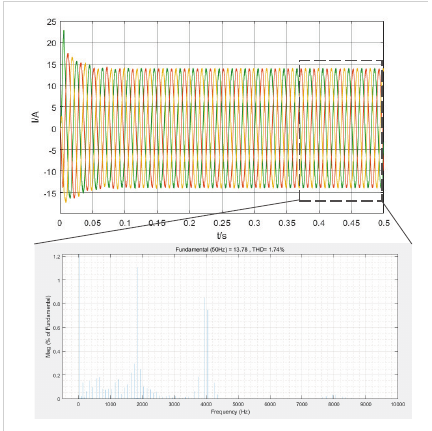
Figure 17. The amount of THD in traditional coordinate when m = 0.6, D = 0.1.